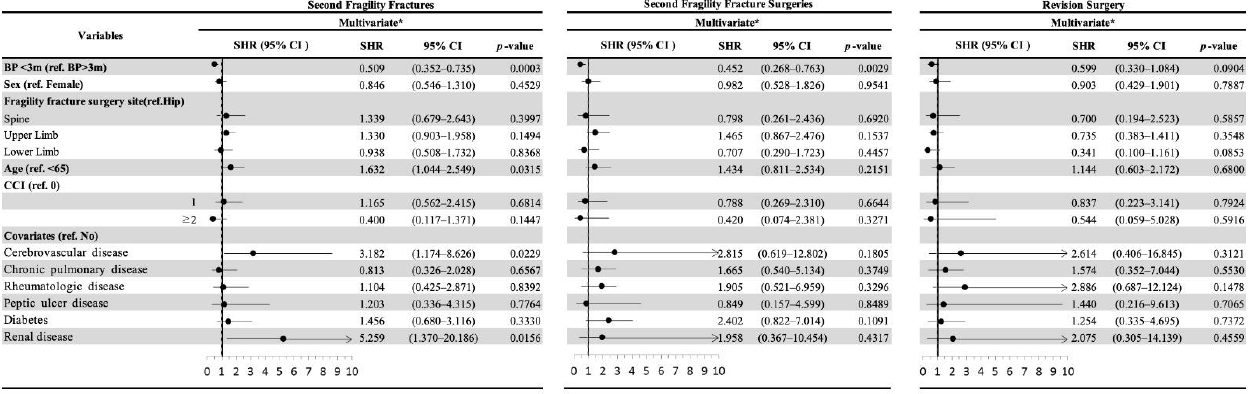
Figure 2. Risk factors and adjusted hazard ratio of fragility fractures stratified by bisphosphonate initiation time, sex, age, Charlson comorbidity index, and comorbidities, by using a proportional subdistribution hazards model. BP: bisphosphonate initiation; CCI: Charlson comorbidity index; CI: confidence interval.